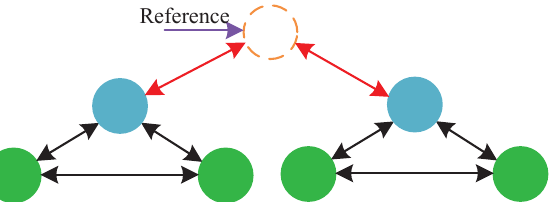
Figure 3. The communication graph topology with the virtual smart leader.